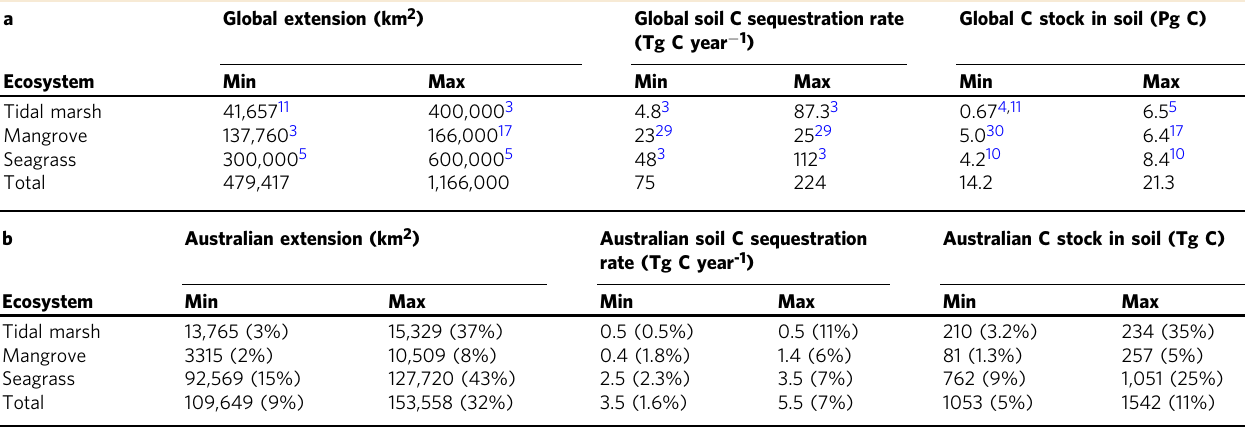
Table 2 Extent, soil organic carbon (C) sequestration rates and stocks (in the top meter of soil) in vegetated coastal